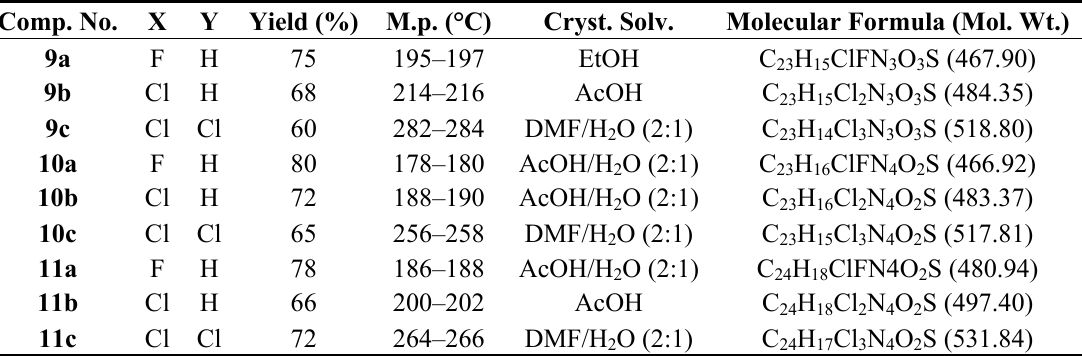
Table 2. Melting points, crystallization solvents, yields, molecular formulae and molecular weights of compounds 9 – 11